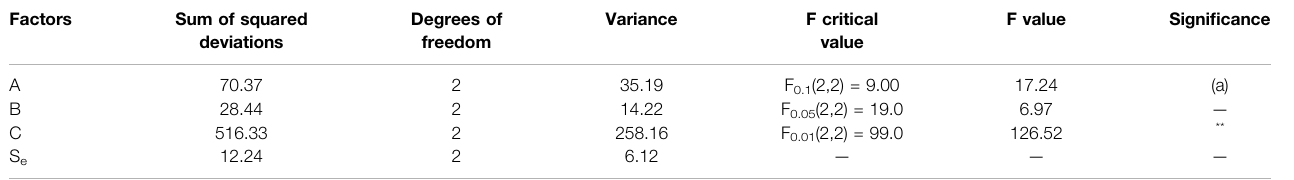
TABLE 12 | Analysis of variance for the compressive strength test.